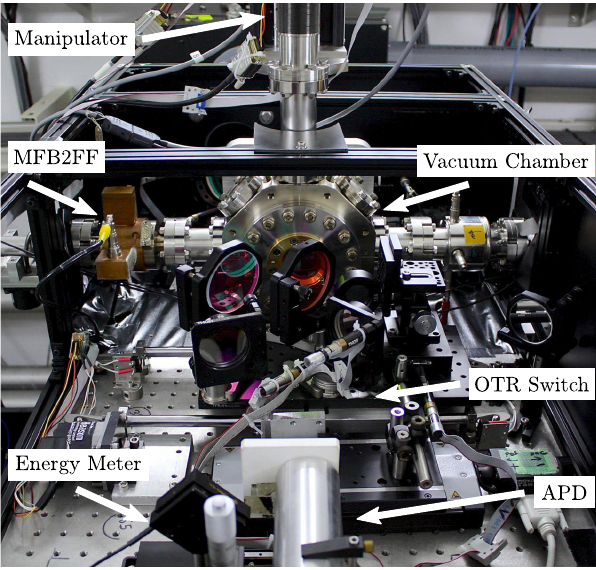
FIG. 2. Photograph of the laserwire installation in the ATF2 beam line. The electron beam travels from right to left and the laser beam enters behind the vacuum chamber and exits towards the reader. The manipulator for the OTR and alignment screen can be seen on top of the vacuum chamber. The avalanche photodiode (APD) used for timing and the laser pulse energy meter can be seen in the foreground. The high resolution CBPM MFB2FF is also shown attached to the laserwire vacuum chamber. The small optical breadboard (OTR switch) allows one to switch between the high power laser path for laserwire and the low intensity OTR path.